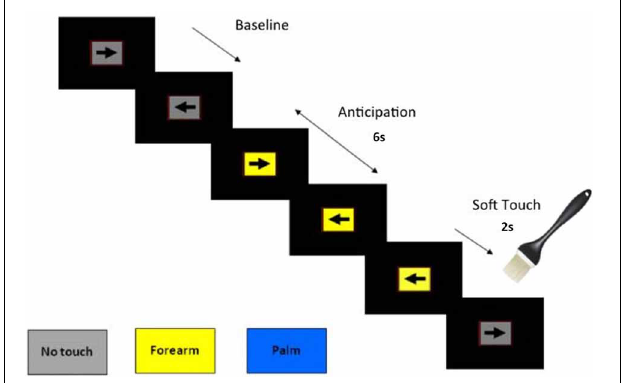
FIGURE 1 | Illustration of Soft Touch continuous performance